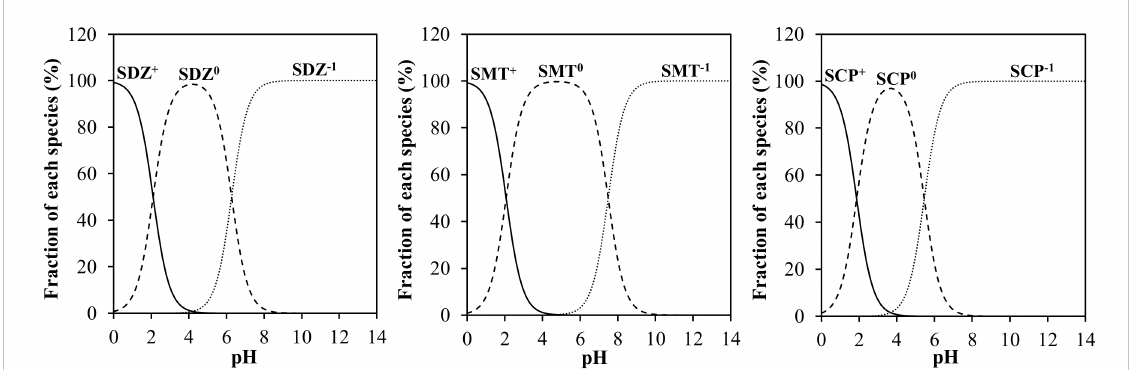
Figure 2. Percentage of each species of sulfadiazine (SDZ), sulfamethazine (SMT), and sulfachlorpyridazine (SCP) as a function of